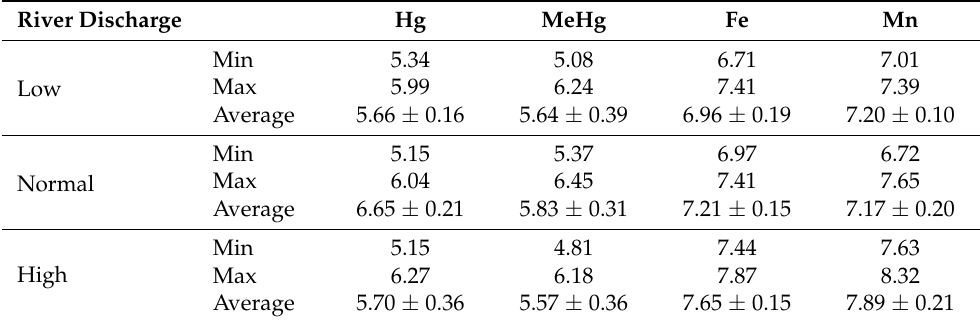
Table 1. Minimum, maximum and average values of logK D (L Kg − 1 ) for Hg, MeHg, Fe and Mn along the Nal ó n River estuary under low, normal and high river